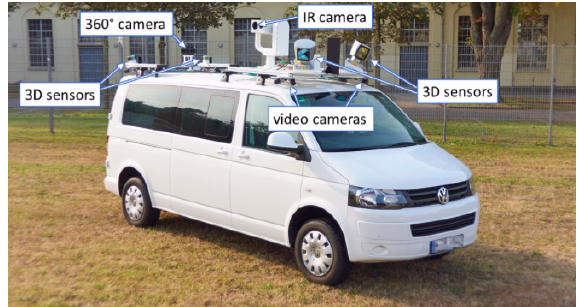
Figure 2. The MODISSA platform from Fraunhofer IOSB.